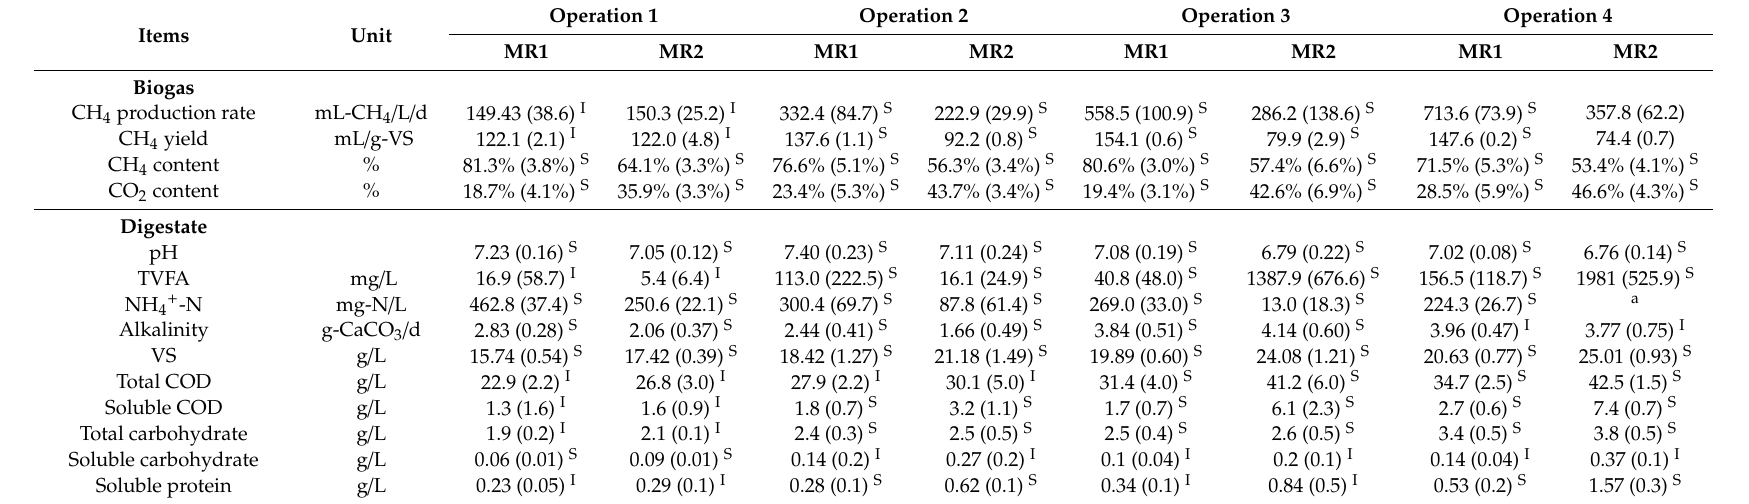
Table 4. The operational performances in two-stage and single-stage CH 4 -reactor at various HRT and